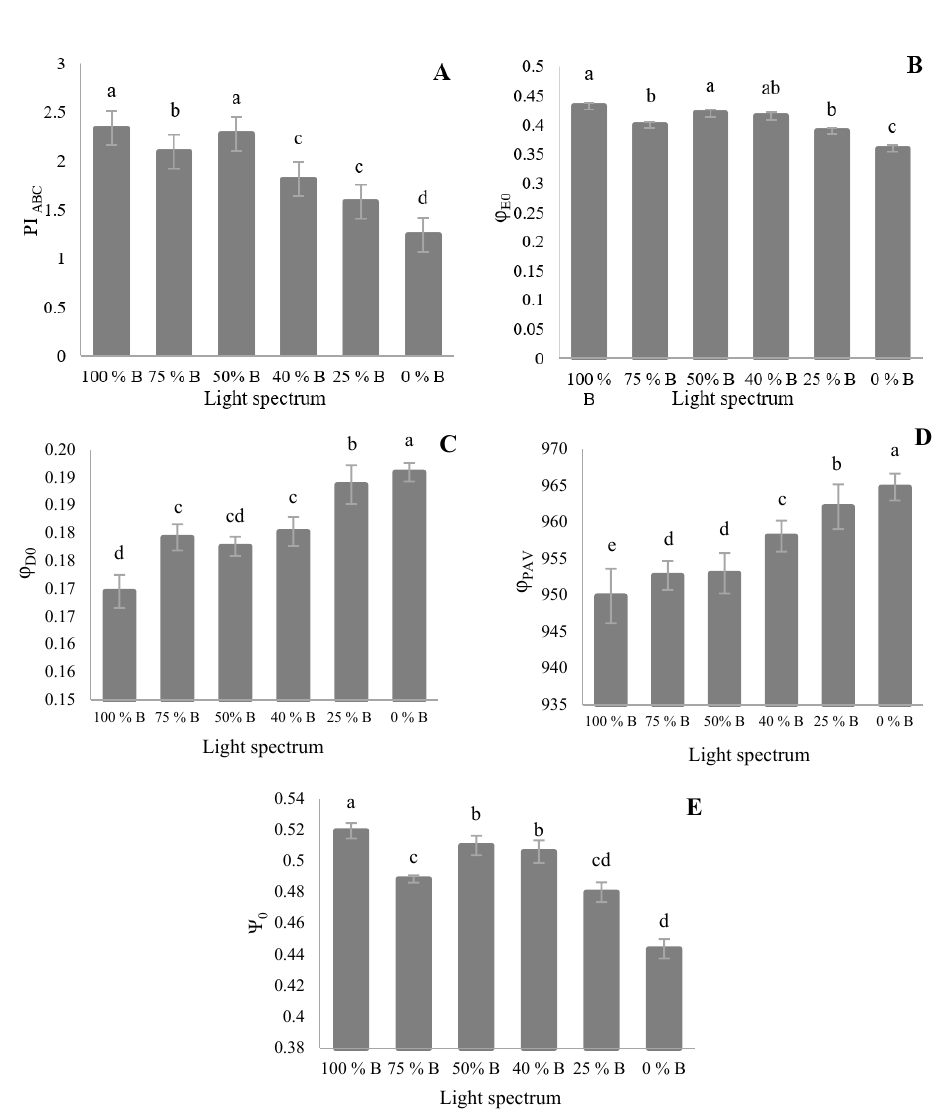
Figure 7. Performance index on the absorption basis ( A ; (PI ABS )), the maximum quantum yield of primary photochemistry, ( B ; ( φ E0 )), quantum yield of energy dissipation ( C ; ( φ D0 )), average (from time 0 to t FM) quantum yield for primary photochemistry ( D ; ( φ PAV )), and the probability that a trapped exciton moves an electron in the electron transport chain beyond Q A − ( E ; ( Ψ 0 ); equation in Table 1) from the fluorescence transient exhibited by leaves of saffron plants grown under different ratios of Blue (B) to Red (R) light in the overall spectral composition, including 100% B, 75% B, 50% B, 40% B, 25% B, 0% B (see the spectrum in Figure 1), with 150 ± 10 µ mol m − 2 s − 1 PPFD. Different letters indicate that values are significantly different at p < 0.01 according to Duncan’s multiple range tests. Bars represent mean value ± standard